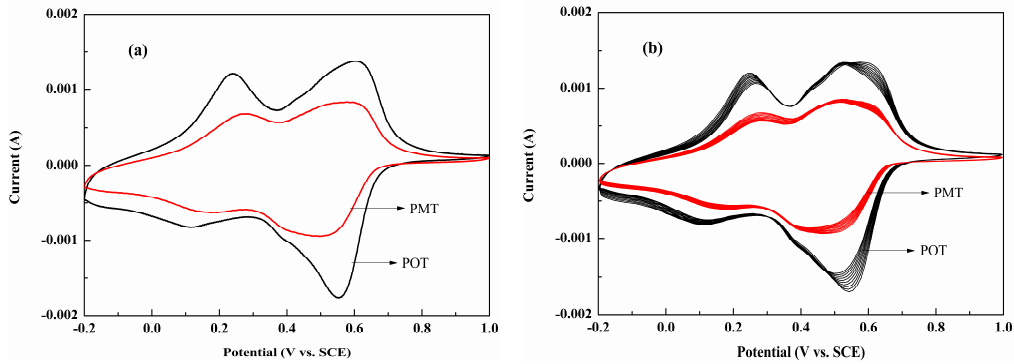
Figure 5. CV curves of POT and PMT films immersed in 1.0 M HCl solution: ( a ) 1 cycle and ( b ) consecutively scanning 10 cycles at 20 mV/s scan rate.